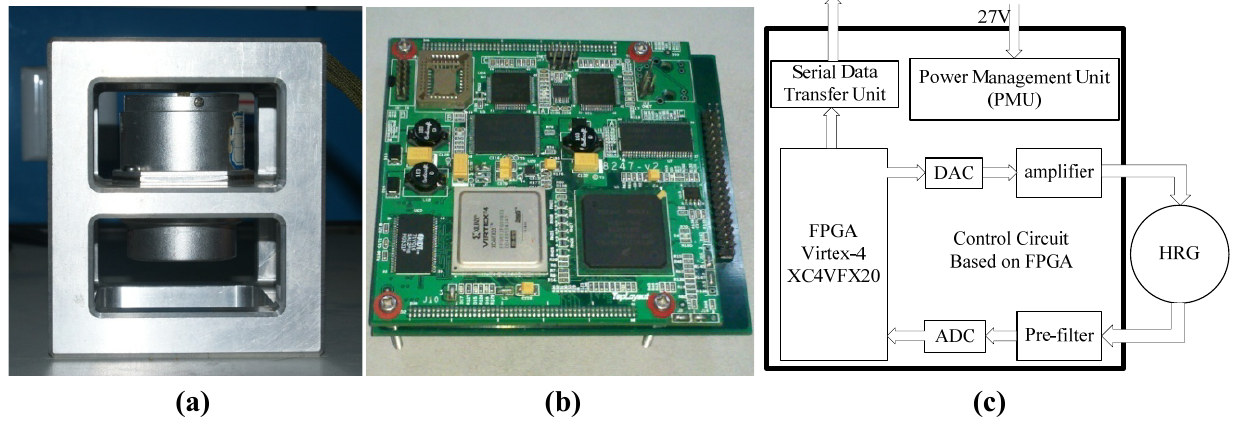
Figure 5. (a) The gauge outfit of HRG. (b) The PCB circuitry of HRG. (c) The overall construction of the